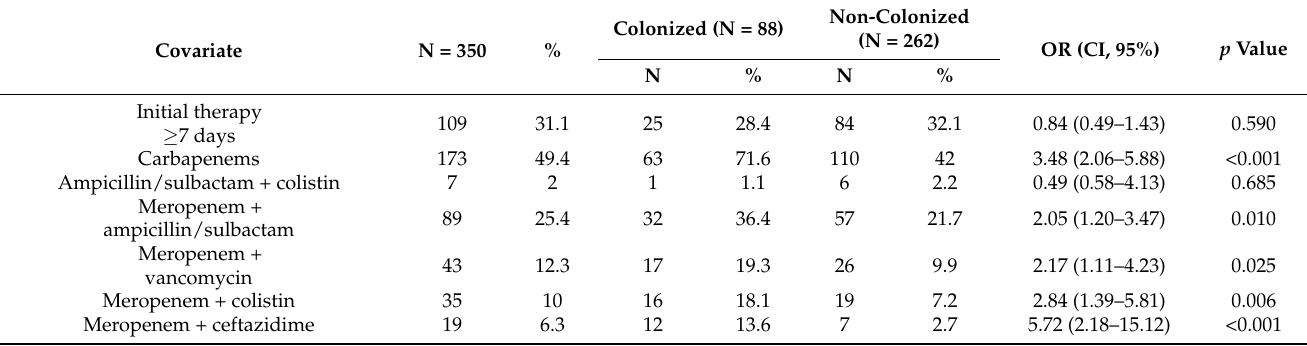
Table 2. Antibiotic therapy in regard to colonization with carbapenem-resistant Enterobacterales (CRE).